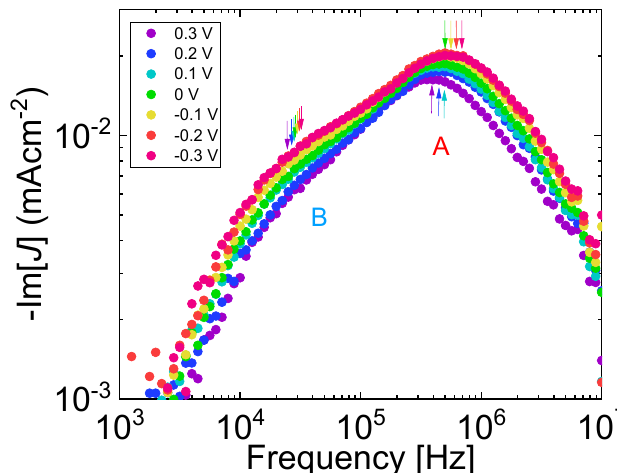
Figure 5. Imaginary part of MPC spectra of 60 wt% PTB7:PC 71 BM inverted OPVs at different applied voltages. Minus signs mean reverse bias voltage. Arrows highlight frequencies from which charge carrier transit times were calculated.